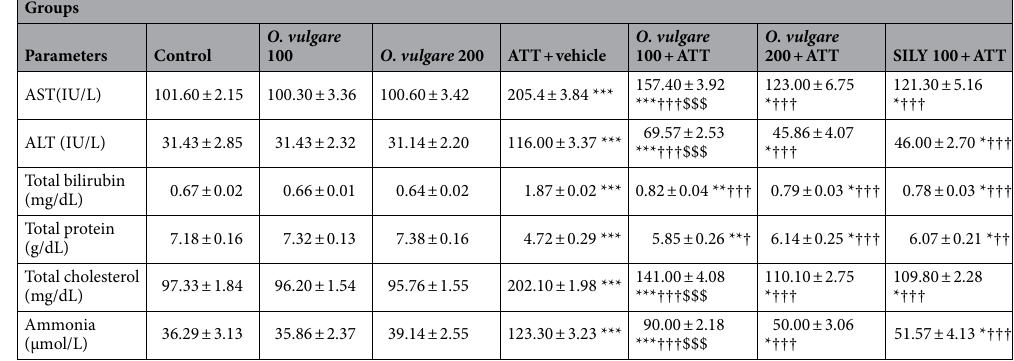
Table 3. The modulatory effects of O. vulgare on serum cellular toxicity markers, and ammonia in the HE rat model. Values are means ± SEM. ALT: alanine aminotransferase, AST: aspartate aminotransferase, O. vulgare : Origanum vulgare , SLY: silymarin. * p < 0.05; ** p < 0.01; *** p < 0.001 (vs. the negative control group); † p < 0.01; †† p < 0.01; ††† p < 0.001 (vs. the HE positive control group, which received vehicle). $$$ p < 0.001 (vs. the HE group, which received silymarin).